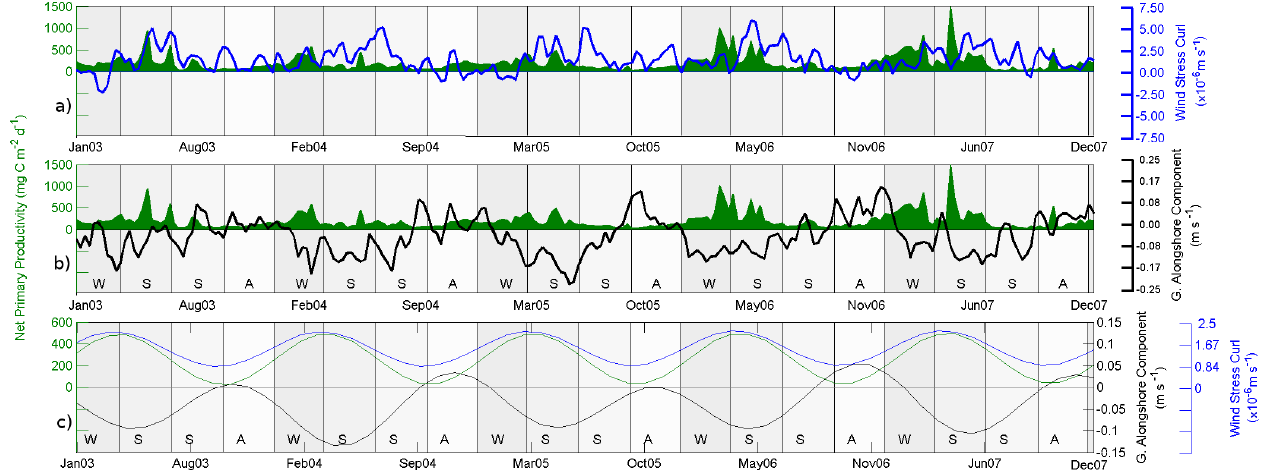
Fig. 6. (a) Time series of net primary productivity (NPP, green shaded) with wind stress curl (WSC, blue solid line) for 2003–2007. (b) Time series of NPP (green shaded) with geostrophic alongshore component (GAC, black solid line) for 2003–2007. (c) Dominant harmonics of the time series of NPP (green line), WSC (blue line) and GAC (black line). The vertical lines and the W, S, S and A letters indicate the seasons.